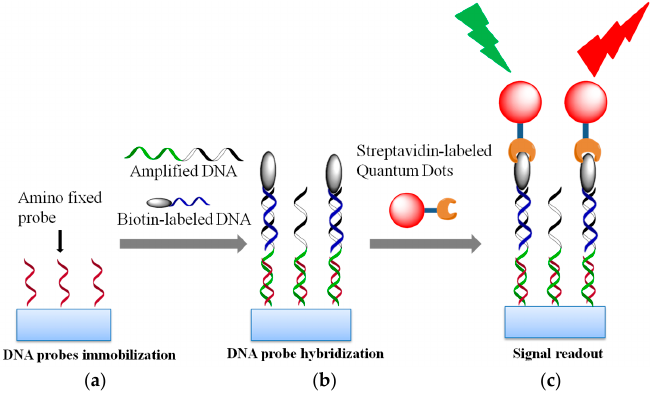
Figure 1. The mechanism of QDs-based fluorescent method for detection of HBV DNA. ( a ) The amino fixed probe was immobilized on a slide; ( b ) The added amplified HBV DNA can hybridize to the amino fixed probe and the biotin-labeled DNA is used to hybridize to the other side of the amplified HBV DNA; and ( c ) The streptavidin-labeled quantum dots combine with the HBV DNA of the patient to form quantum dot-DNA complexes through the reaction of biotin and streptavidin. Figure 2. The complementarity of amplified DNA, capture and reporter probes. The mutation site was marked in red color. Amplified DNA: 3 (cid:48) -ATTTTTCCCTGAGTTCTACGACATGTCTGAACCGGGGGTTATGGTGATAATCCATATAACTGA-5 (cid:48) . Capture probe: NH 2 -5 (cid:48) TTTTTTTTTTTAAAAAGGGACTCAAGATGCTGTACAGACTTGGCC-3 (cid:48) . Reporter probe: 5 (cid:48) -TATTAGGTATATTGACTTTTTTTTTTT-3 (cid:48) -biotin.